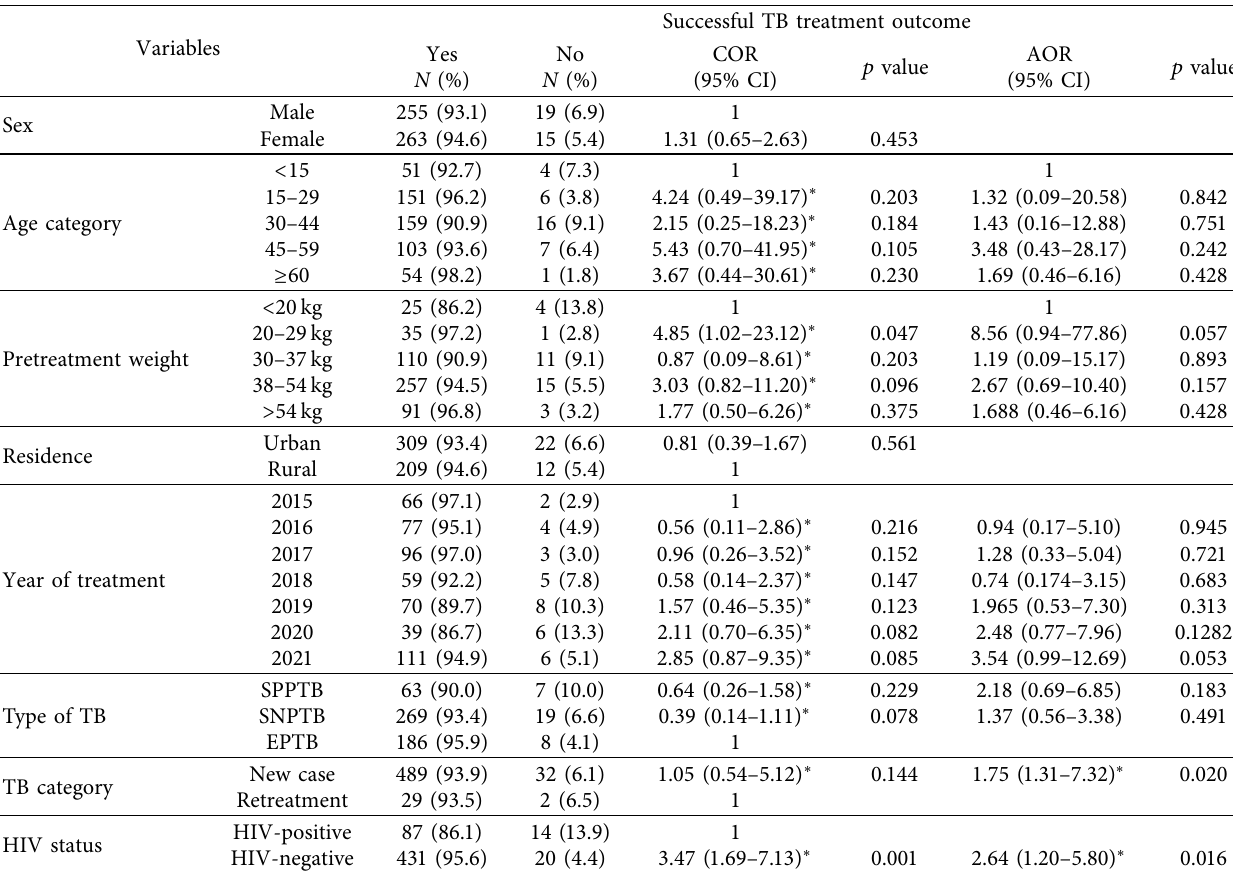
Table 4: Bivariate and multivariate analysis of treatment outcome with socio-demographic and clinical characteristics of TB patients at Tefera Hailu Memorial General Hospital, Sekota town, Northeast Ethiopia from 2015 to